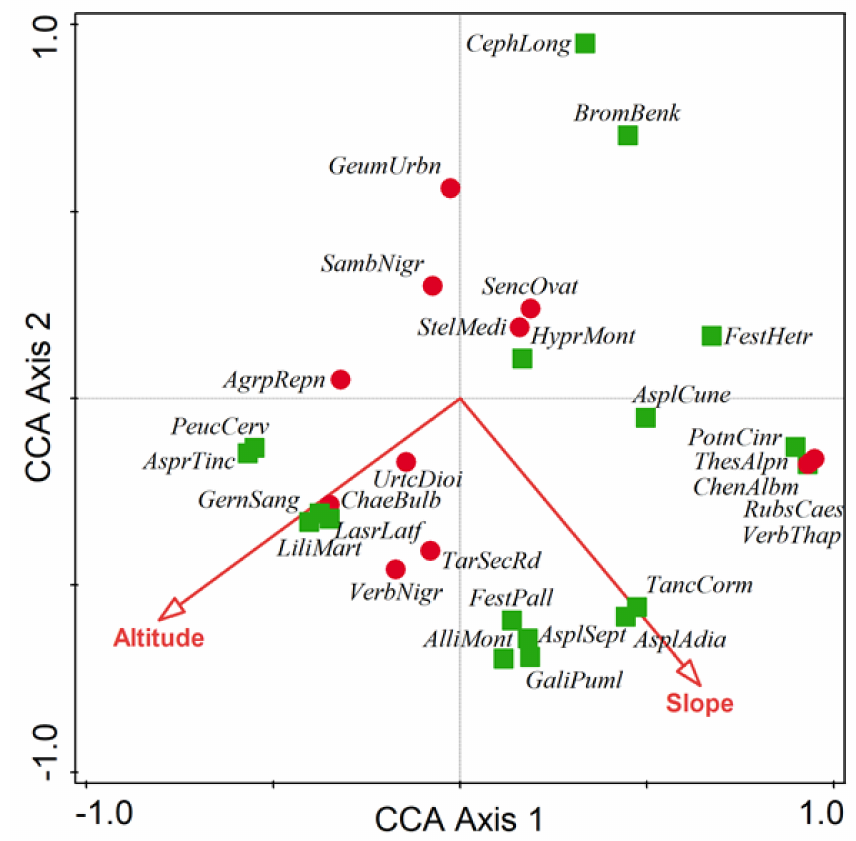
Figure 6. CCA distribution diagram of nitrophilic (red circles) and rare/endangered species (green squares) recorded in serpentine forest communities in SW Poland. Species scores limit to 30 by weight. Abbreviations of species names are in accordance with these presented in Tables 2 and